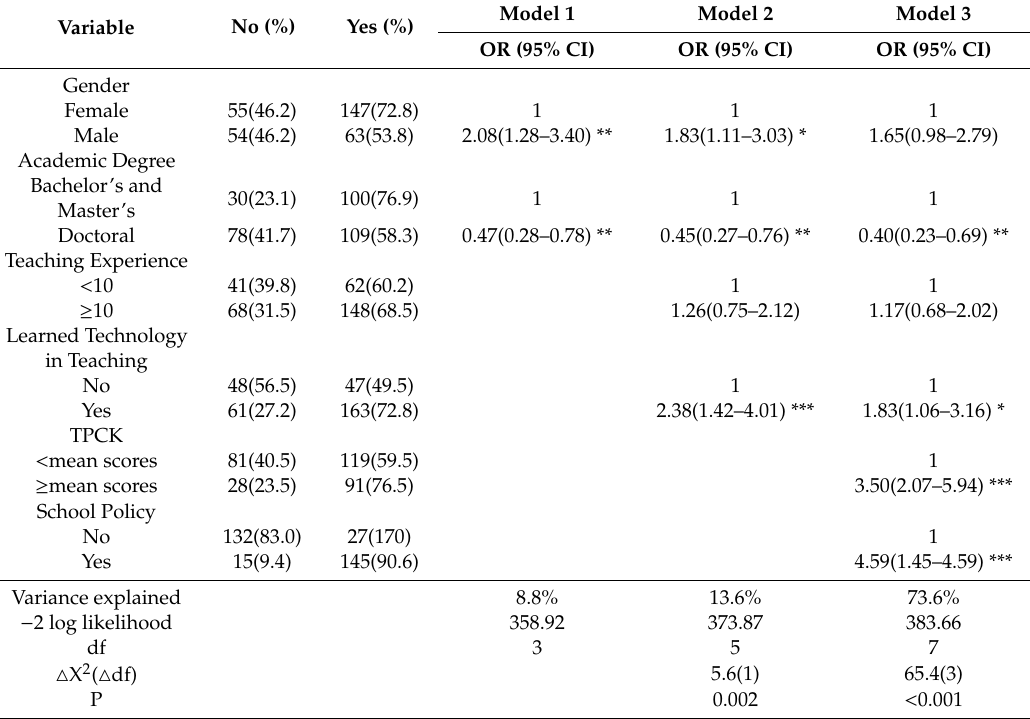
Table 4. Multivariable logistic regression model for technology integration in the